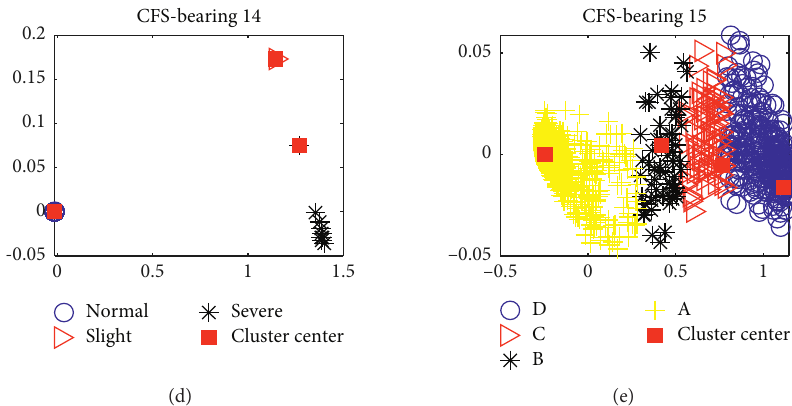
Figure 13: Two-dimensional clustering result by using the SDAE and CFS for bearings 11–15. A: Normal1; B: Normal2; C: Slight; D: Severe. (a) CFS-bearing 11. (b) CFS-bearing 12. (c) CFS-bearing 13. (d) CFS-bearing 14. (e) CFS-bearing 15.